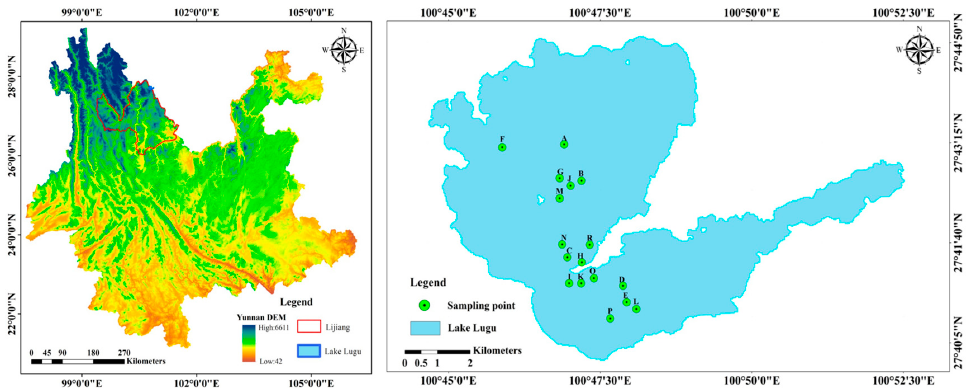
Figure 1. Distribution of monitoring and sampling sites in Lake Lugu.